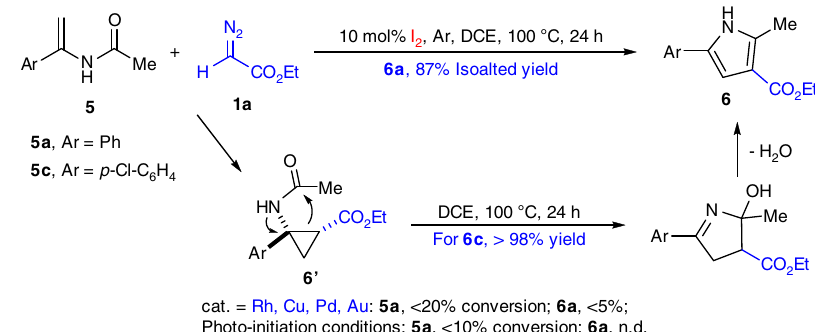
Fig. 5 Thermally initiated iodine-catalyzed pyrrole synthesis. Generation pyrrole from the key cyclopropane intermediate 6 ′